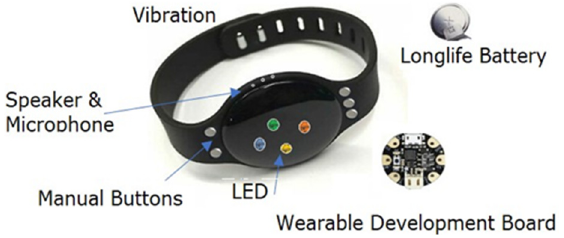
Figure 9. Wristband for vulnerable people.